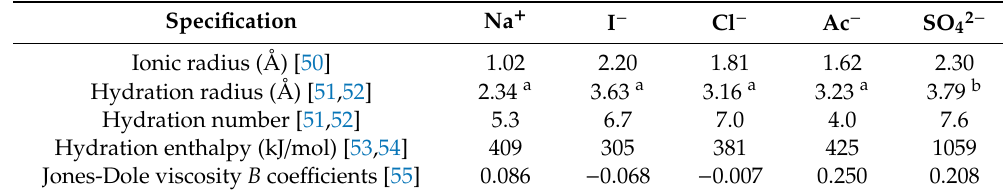
Table 2. Specifications of cations and anions discussed in this